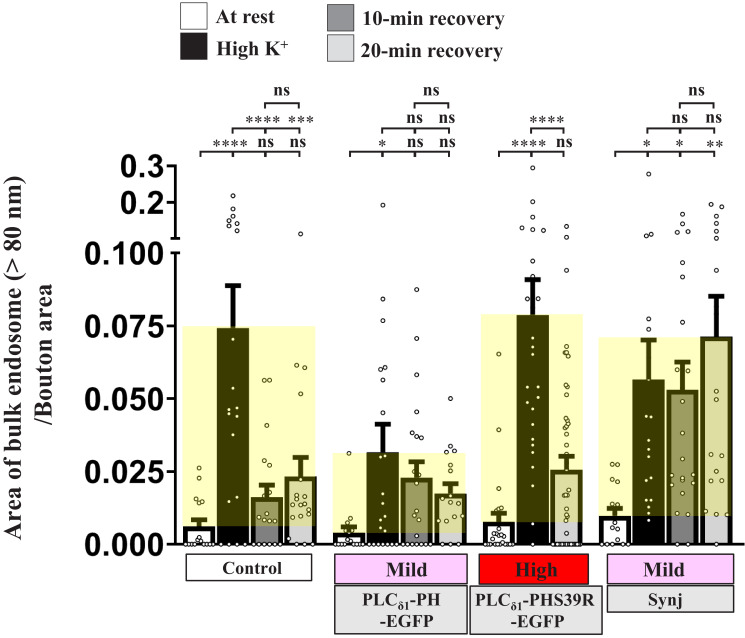
Blockade of the PI(4,5)P2 microdomains abolishes SV reformation from the bulk endosome.Quantification data for the ratio of total area of bulk endosomes to bouton area. Indicated genotypes were assessed. Representative TEM images are shown in Figure 2c. Individual data values are shown in graphs. p values: ns, not significant; *p<0.05; **p<0.01; ***p<0.001; ****p<0.0001. Mean ± SEM. Statistics: one-way ANOVA with Tukey’s post hoc test.
Figure 2—figure supplement 2—source data 1.Source data for Figure 2—figure supplement 2.